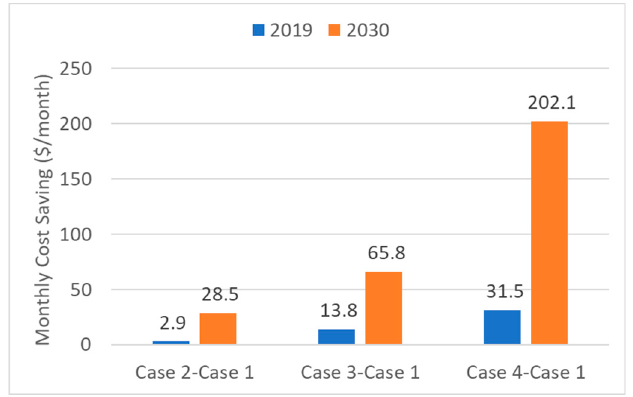
Figure 10. Monthly cost saving per EV under varying DR programs in 2019 and 2030: ( a ) 2019; ( b ) 2030.